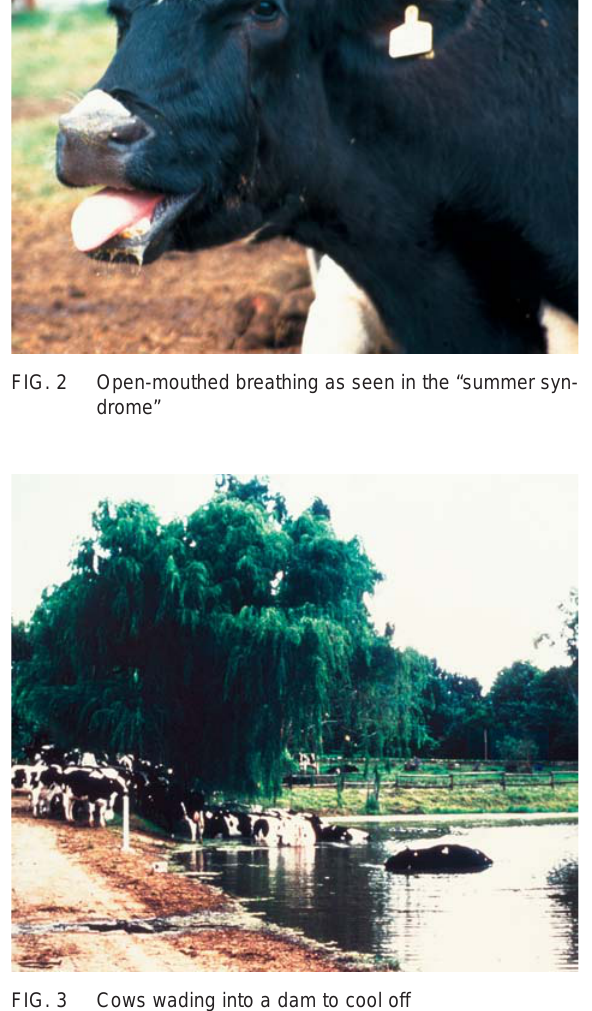
FIG. 3 Cows wading into a dam to cool